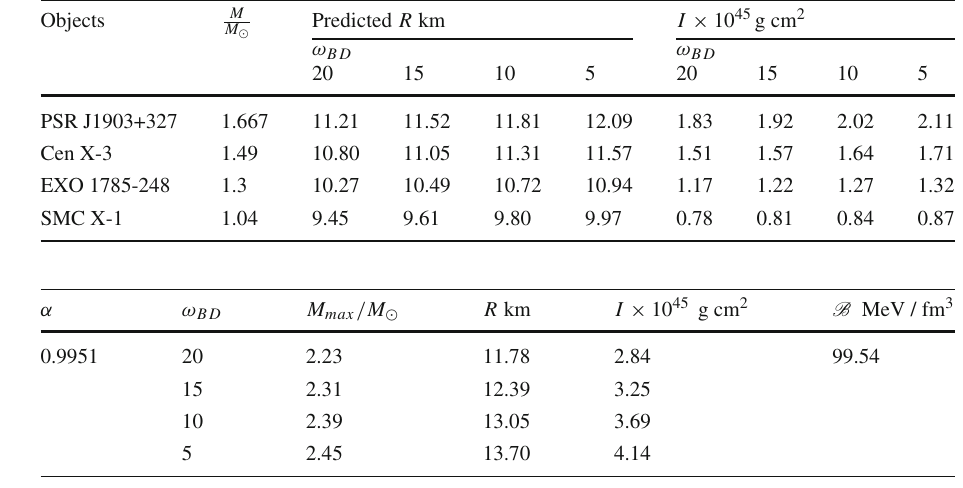
Table 3 Predicted radii and MI for some compact stars for different values of ω with α = 0 . 9951 ,β = − 0 . 0092819 ,Φ = 1 . 001134 0 correspond to Fig. 8